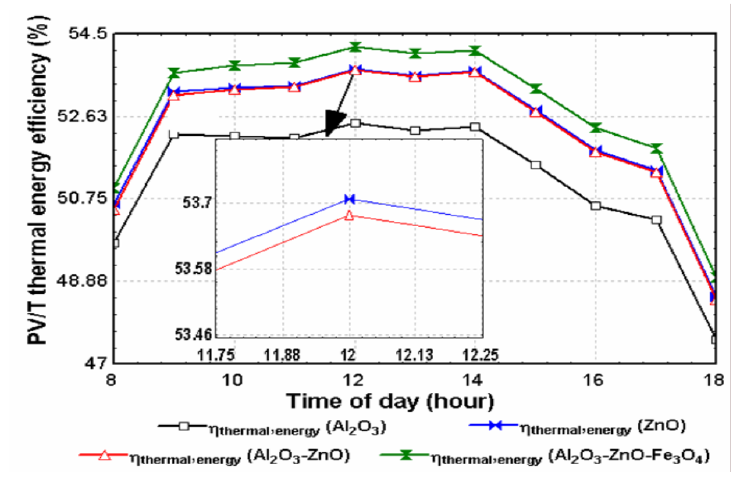
Figure 13. PV/T performance in thermal analysis.